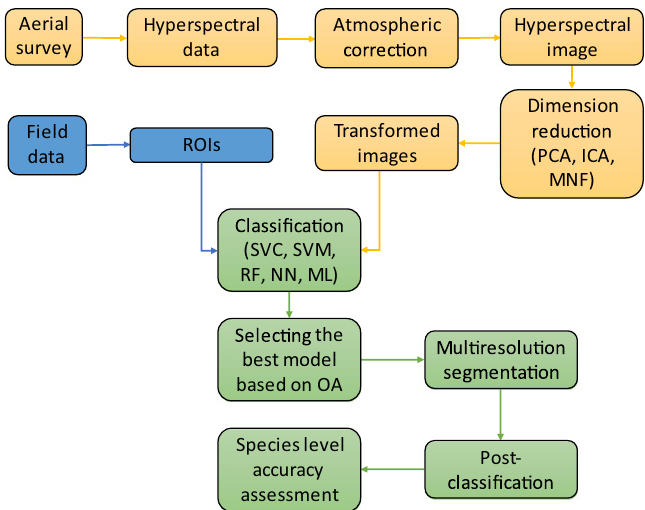
Figure 10. Workflow of image processing and post-classification. ROIs training pixels by Region of Interests, OA overall accuracy, MNF Minimum Noise Fraction, PCA Principal Component Analysis, ICA Independent Component Analysis, ML Maximum Likelihood, SVM Support Vector Machine, SVC Linear type of SVM, RF Random Forest, NN Neural